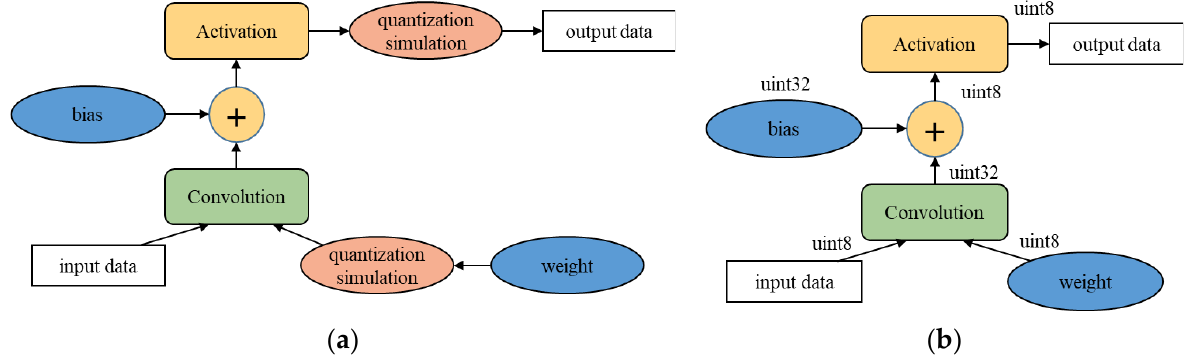
Figure 11. Quantization aware training. ( a ) Network architecture for the simulation of the quantized network; ( b ) quantized network after QAT.